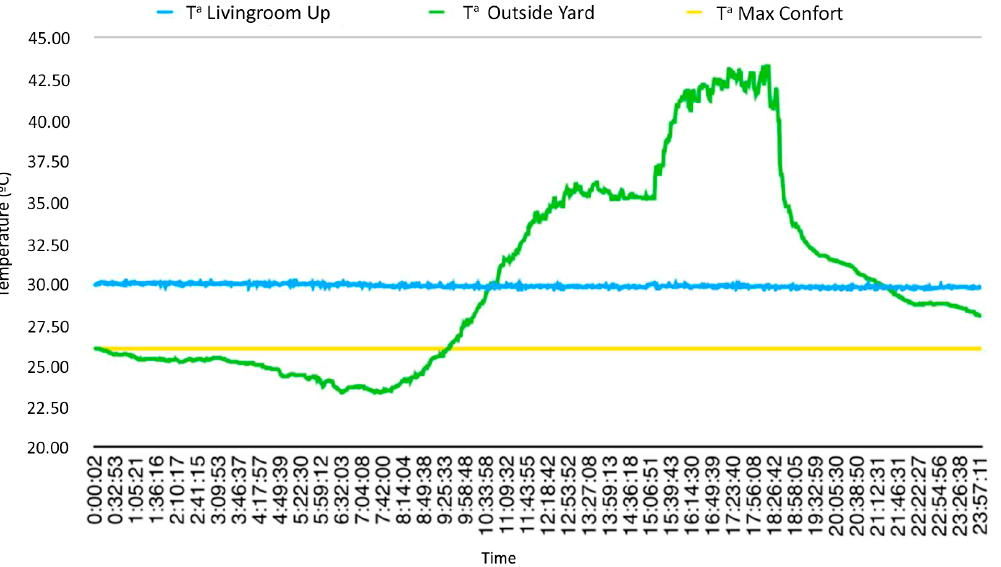
Figure 21. Variation of the dwelling indoor temperature without opening windows and skylight.